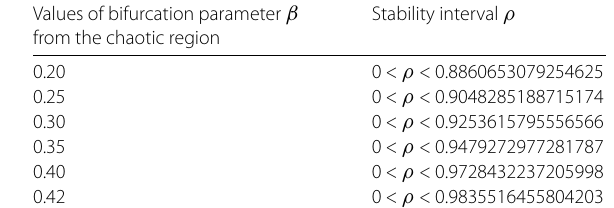
Table 2 Controllable interval for system (38) with various values of r in the chaotic region